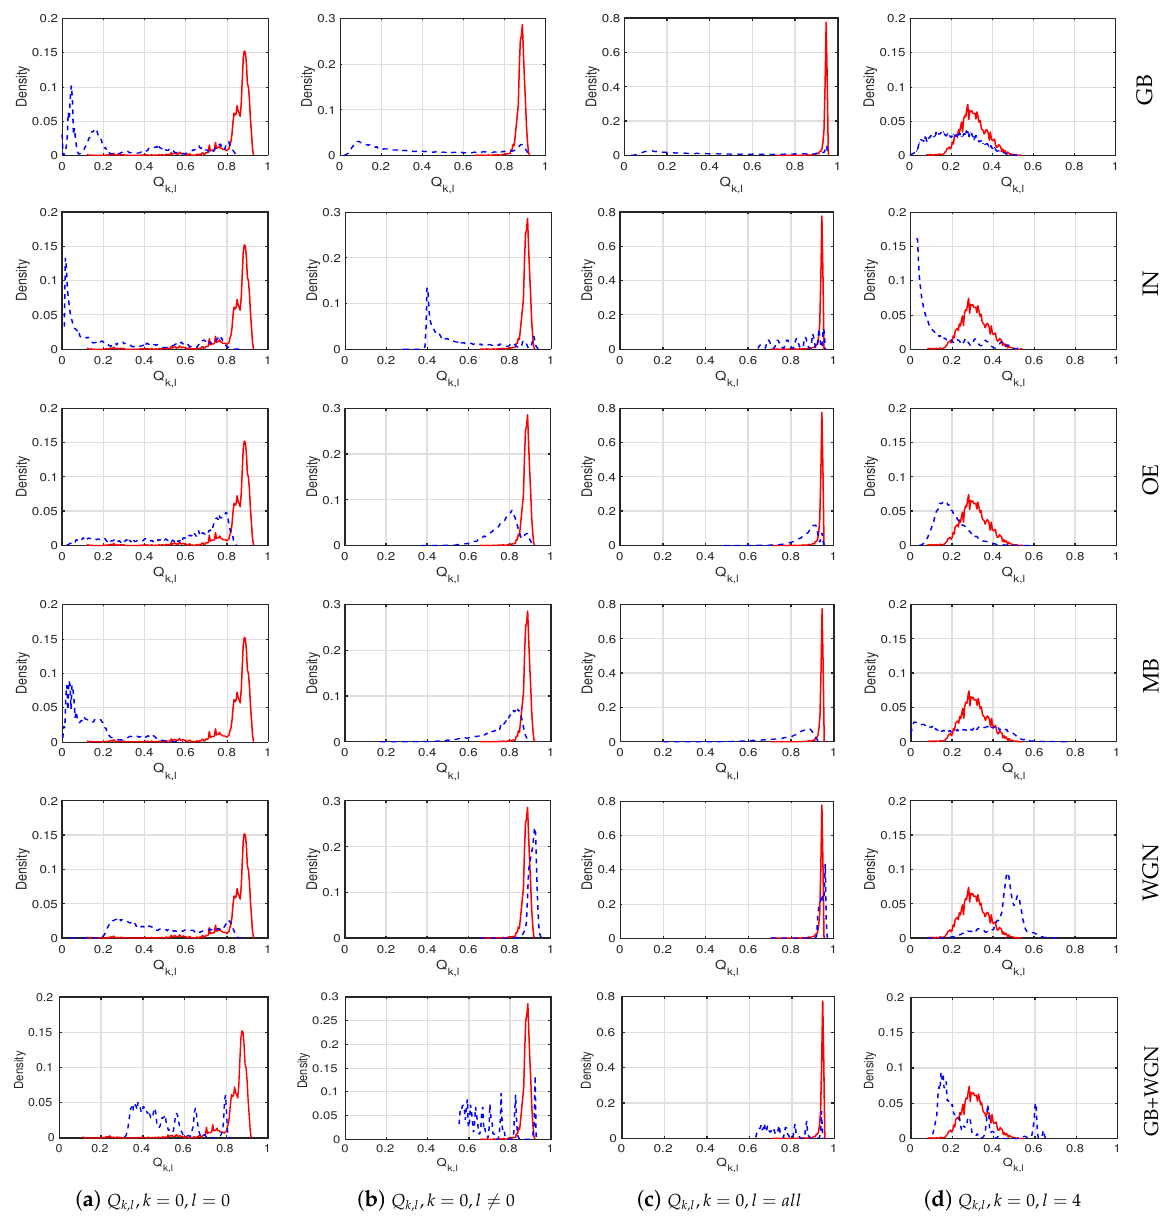
Figure 2. The solid red lines show the distributions of the quality scores of the high-quality iris images, and the dotted blue lines show the distributions for the distorted versions with different distortion types, which are shown on the right side of each row. The quality scores Q k , l are formed based on four different coincidences of sign ( k ) and magnitude ( l ) patterns, shown at the bottom of each column. The first column shows the histograms of the quality score Q 0,0 , and the second, third, and fourth columns show the histograms of the coincidence patterns Q 0, l with l (cid:54) = 0, l = all, and l =